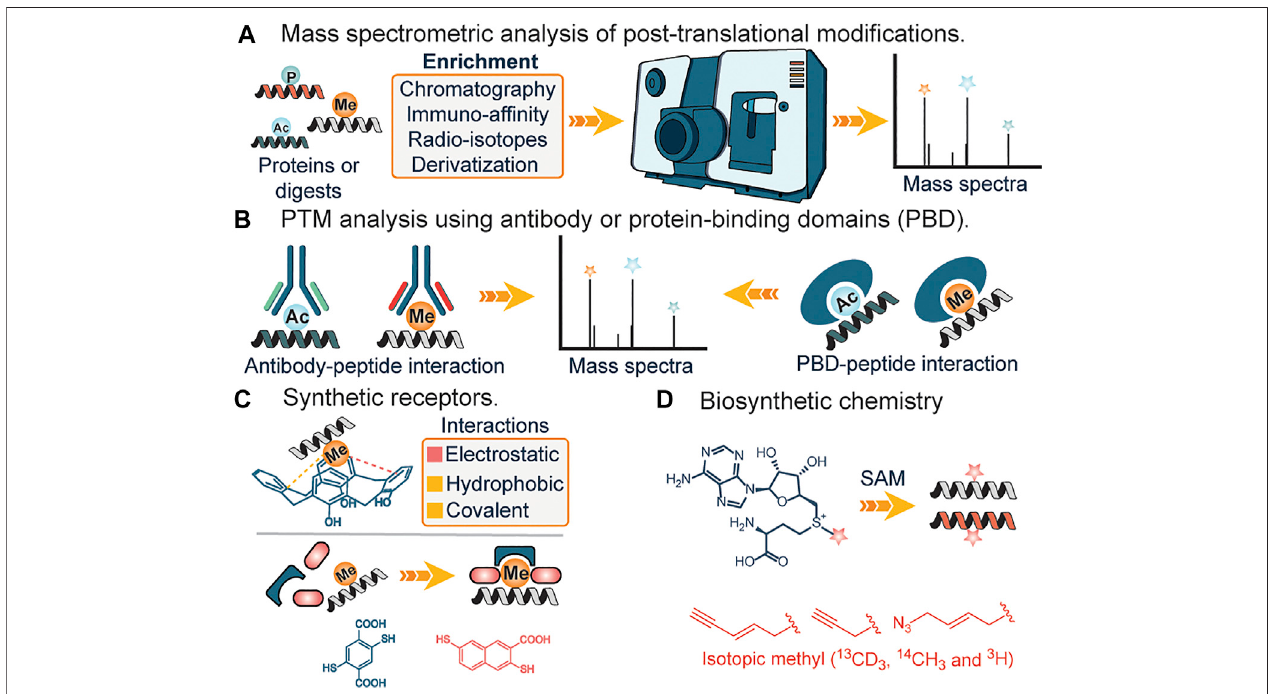
FIGURE 2 | (A) Analysis of PTMs using mass spectrometry. (B) Analysis of PTMs using antibody and protein-binding domains. (C) Interactions of synthetic receptors and PTMs (methylation). (D) Biosynthetic analogs of s-adenosylmethionine for af fi nity tag or isotopic tag labeling of lysine methylation.